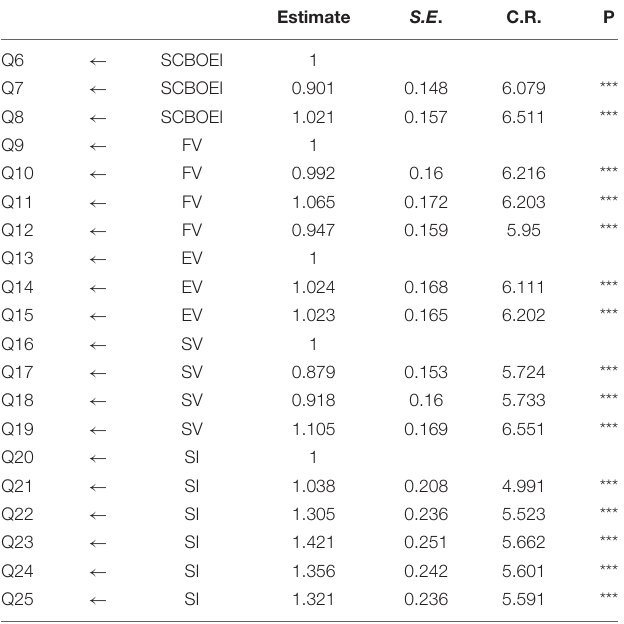
TABLE 6 | Regression weights in CFA.